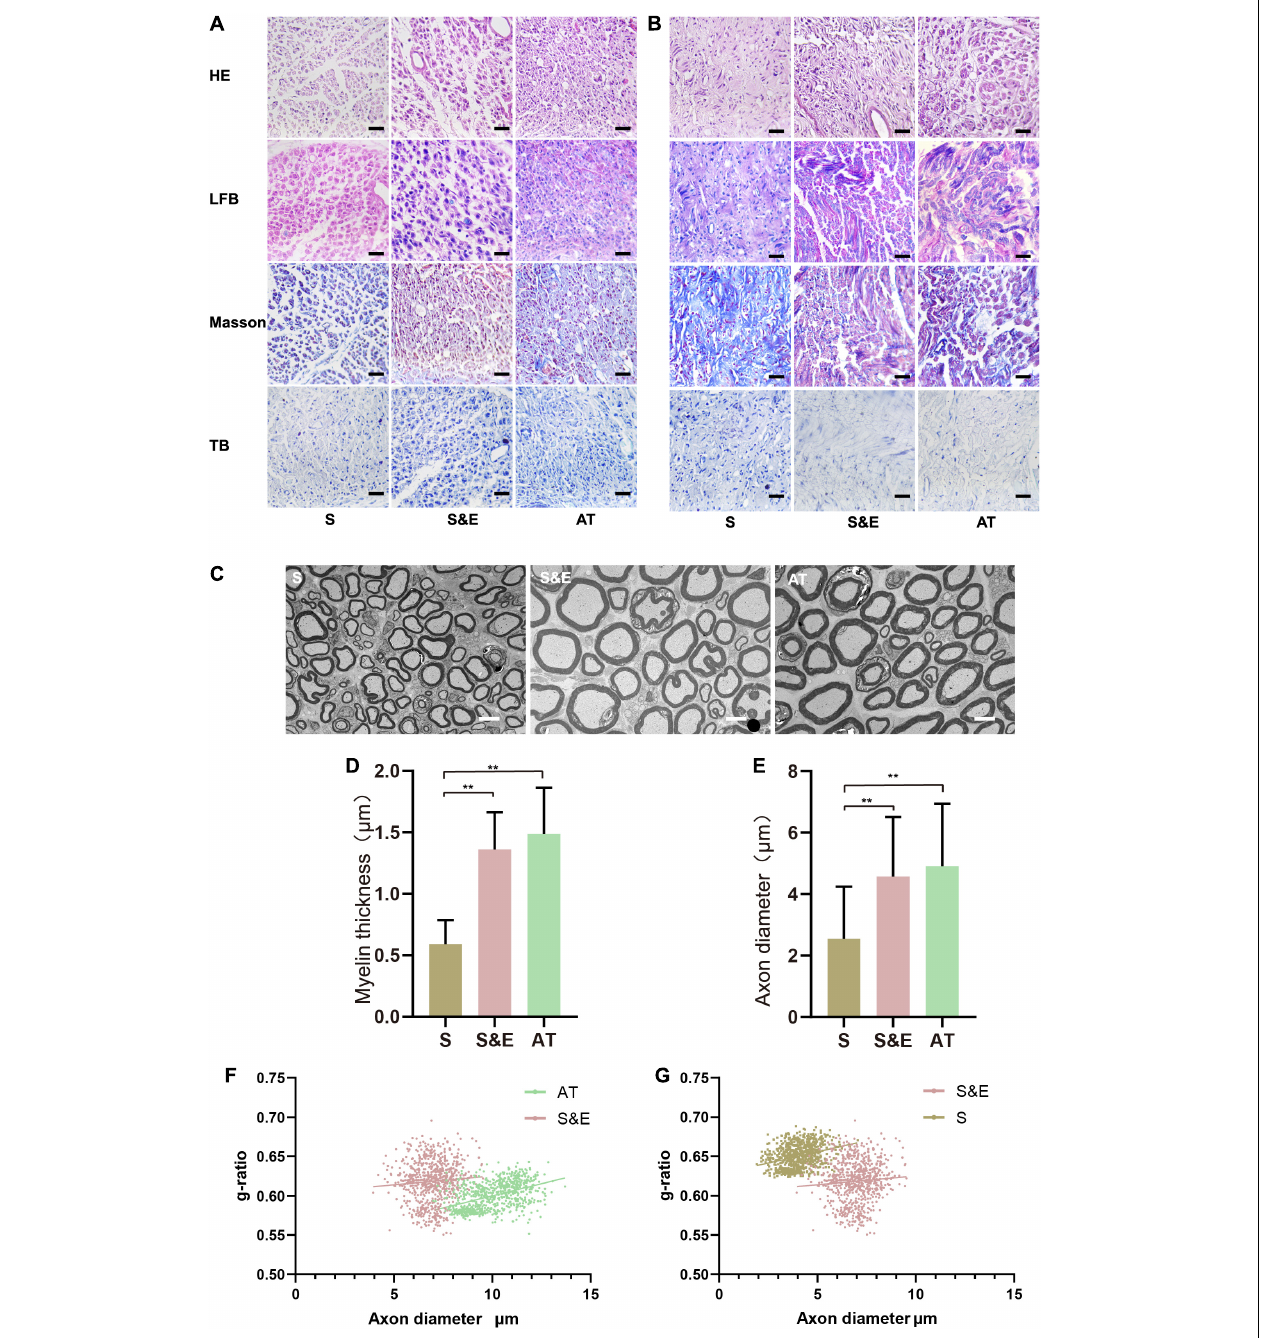
FIGURE 8 | H&E, LBF, Masson’s trichrome, and TB staining images of the regenerated nerves. (A) The images at the 8th week after implantation. Scale = 25 µ m. (B) The images at 12th week after implantation; scale = 25 µ m. (C) The TEM images at 24th week after implantation; scale = 5 µ m. (D,E) Statistical results of myelin sheath thickness and axonal diameter at 24th week after implantation ( n = 5, ** p < 0.01). (F,G) g -ratios of the regenerated nerve at 24th week after implantation. The g -ratio of Group AT was lower than that of Group S&E ( p < 0.01), and the g -ratio of Group S&E was lower than that of Group S ( p < 0.01). LBF, Luxol Fast Blue; TB, Toluidine Blue; TEM, transmission electron microscopy.